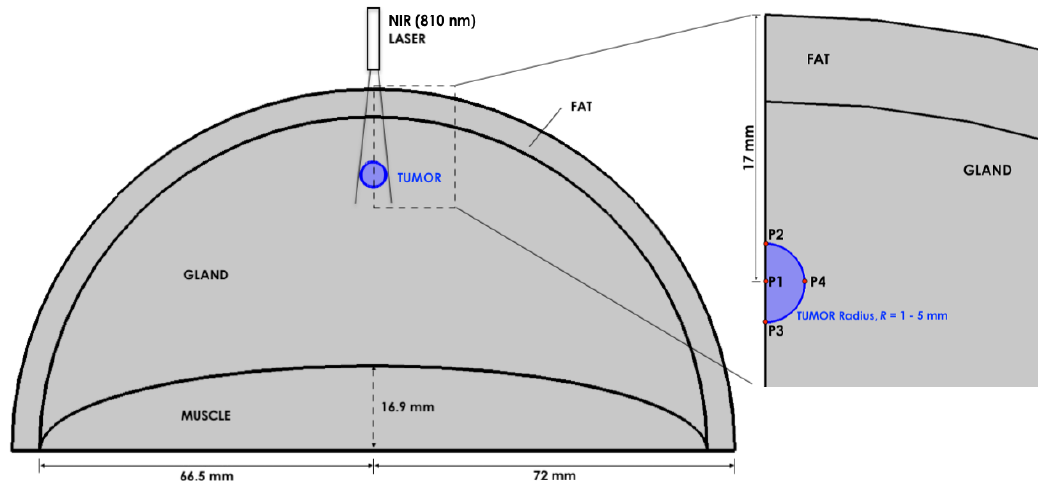
Figure 3. FEM geometry. Schematic of the photothermal therapy consisting of a normal multi-tissue breast domain with an embedded spherical tumor (blue sphere) and NIR (810 nm) laser source. Inset: Fragment of geometry showing controls point P1 − P4, where temperature were